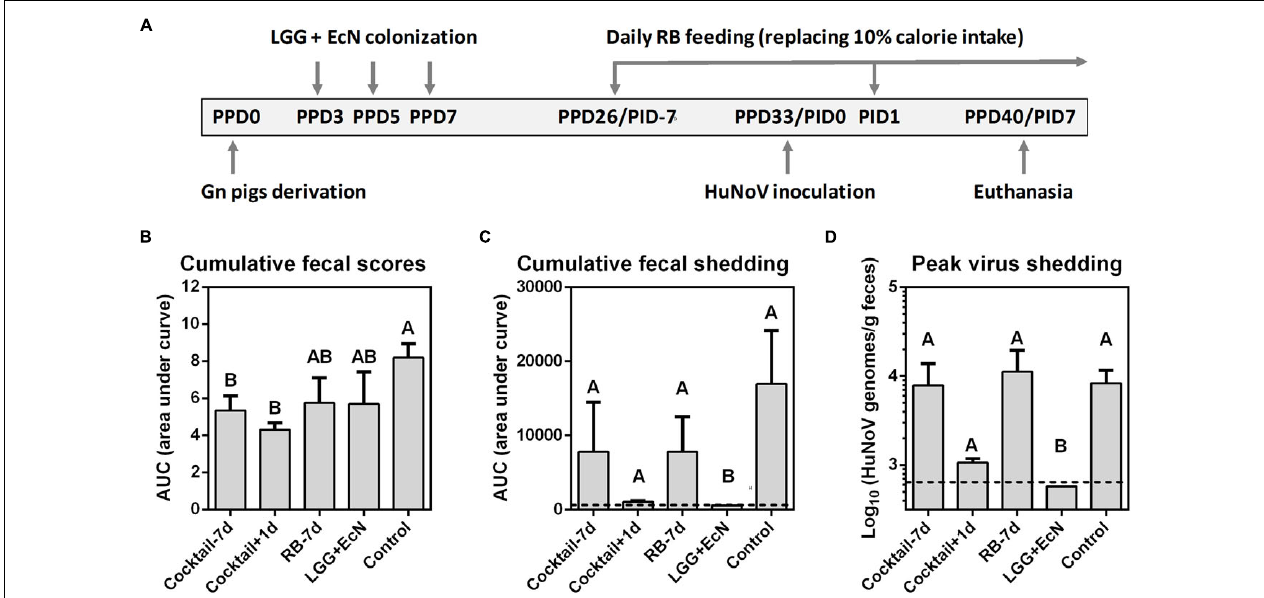
FIGURE 2 | Design and summary of Gn pig study. (A) Experimental timeline. PPD, post-partum day; PID, post-inoculation day. Cumulative fecal scores (B) and shedding (C) are shown as area under curve from daily measurements of individual pigs (Supplementary Figure S1). (D) Mean peak virus shedding titers from PID1 to PID7 in individual pigs. Sample sizes are shown in Table 1 . Data are presented as mean ± SEM. Dashed lines indicate limit of detection. Statistics were determined by Kruskal–Wallis test. Different letters indicate significant differences among groups ( P < 0.05), while shared letters indicate no significant difference.